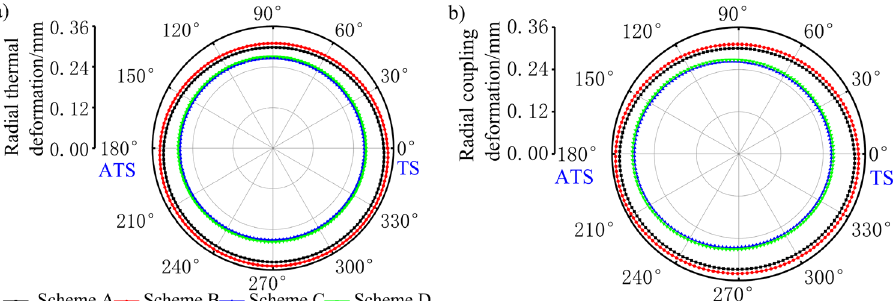
Table 6. Comparison of thermal stress and coupling stress at key positions of the piston.